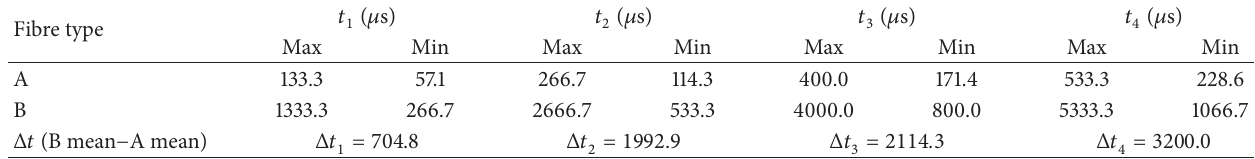
Table 2: Timing of AP propagation in A- and B-fibres between longitudinal